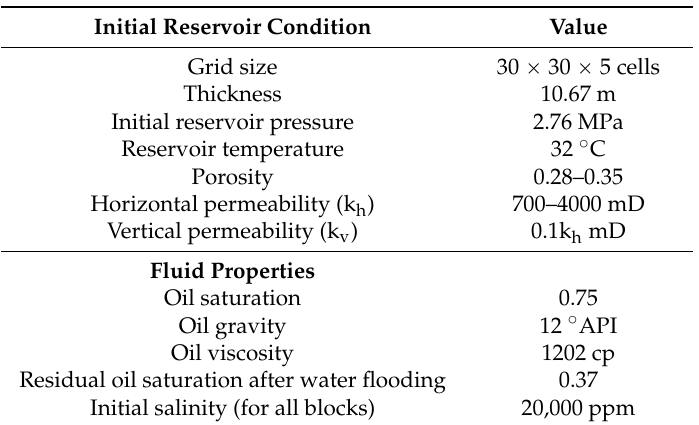
Table 1. Parameters used for the initial reservoir